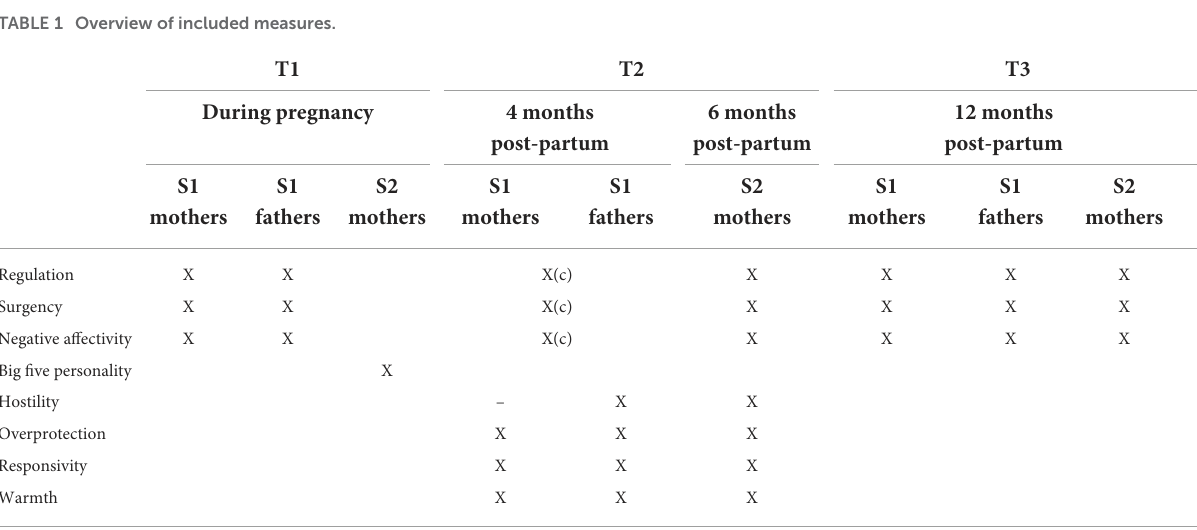
TABLE 1 Overview of included measures.